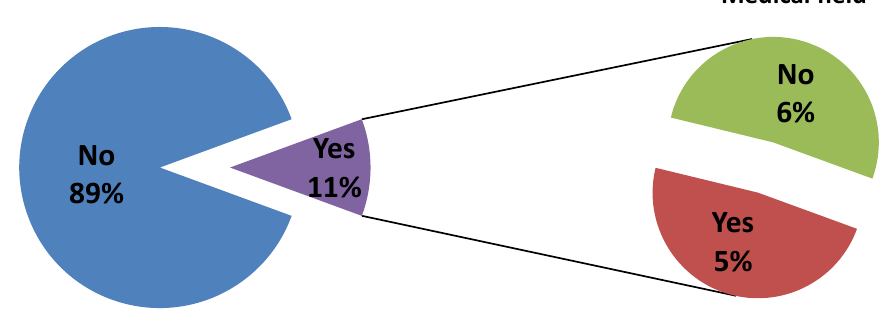
Figure 5. Pie chart of answers related to habits of self-inspection.